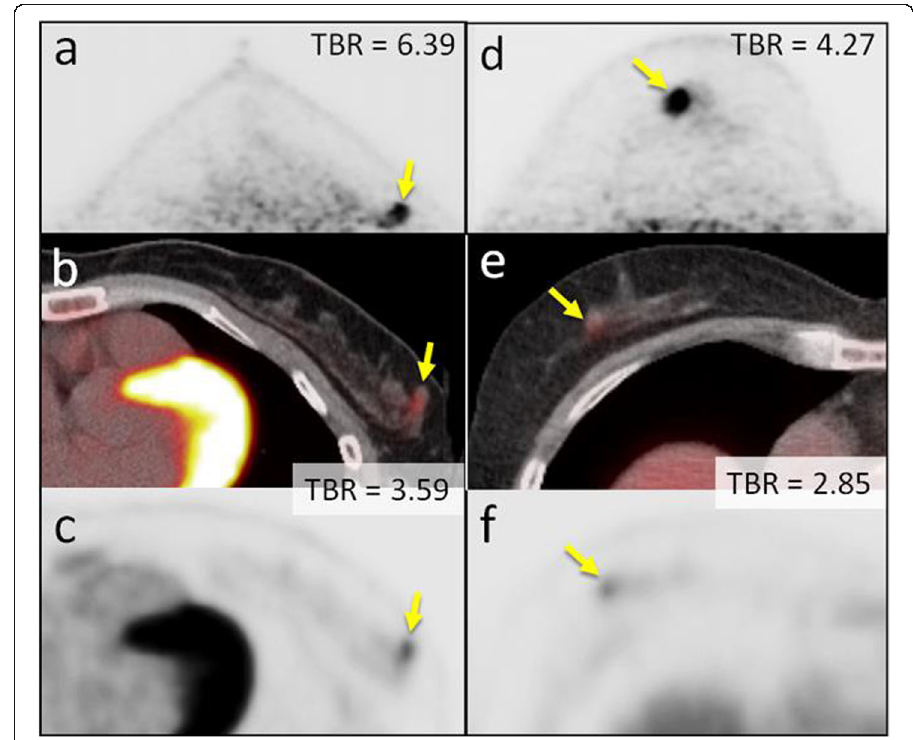
Fig. 6 Peripheral and non-peripheral breast cancer images of dbPET scanned in the prone position and whole-body PET/CT scanned in the supine position. Representative clinical images of peripheral (39-year-old woman; clinical size, 12 mm; a – c ) and non-peripheral (63-year-old woman; clinical size, 9 mm; d – f ) breast cancers on dbPET ( a , d ), PET/CT ( b , e ), and PET ( c , f ) with focal FDG uptake in the background mammary gland tissue. Although the focal uptakes were visualised on both the dbPET and whole-body PET/CT images, it was obvious on dbPET with a higher TBR than that on whole-body PET/CT, regardless of the peripheral or non-peripheral